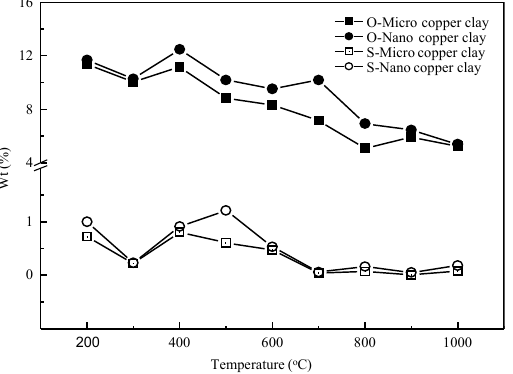
Figure 5. The percentage by weight of sulfur (S) and oxygen (O) in the sintered nano- and micro- copper clay specimens determined by SEM-EDS.